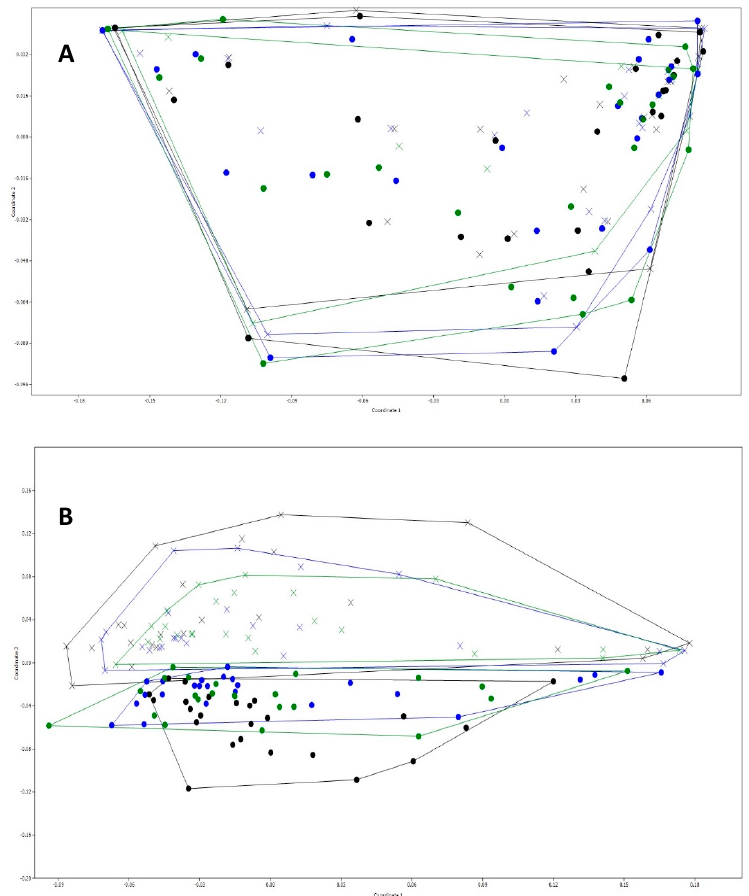
Figure 3. Non-metric multidimensional scaling (NMDS) plot comparing bacterial communities between treatments in both groups combined ( p <0.05). ( A ) 0 h and ( B ) 24 h. ● : negative control (NC), x : fructooligosaccharides (FOS), ● : black sorghum bran extract (BSE), ● : sumac sorghum bran extract (SSE), x : FOS + BSE, x : FOS + SSE.